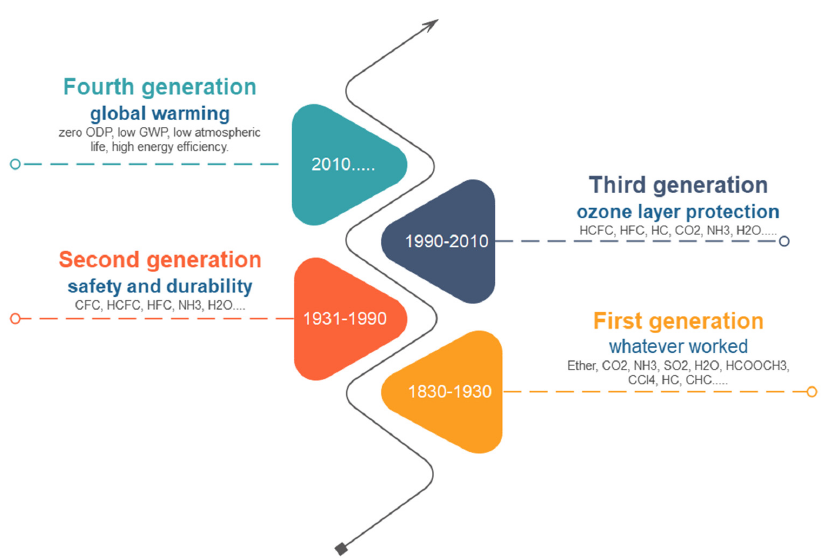
Figure 1. Generations of refrigerant.